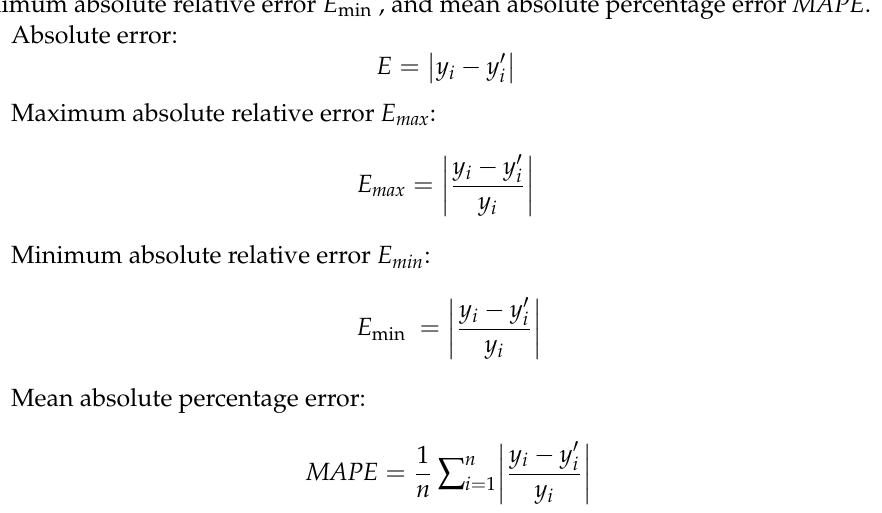
Table 3. The predicted values of the training set in the four models and their relative errors.